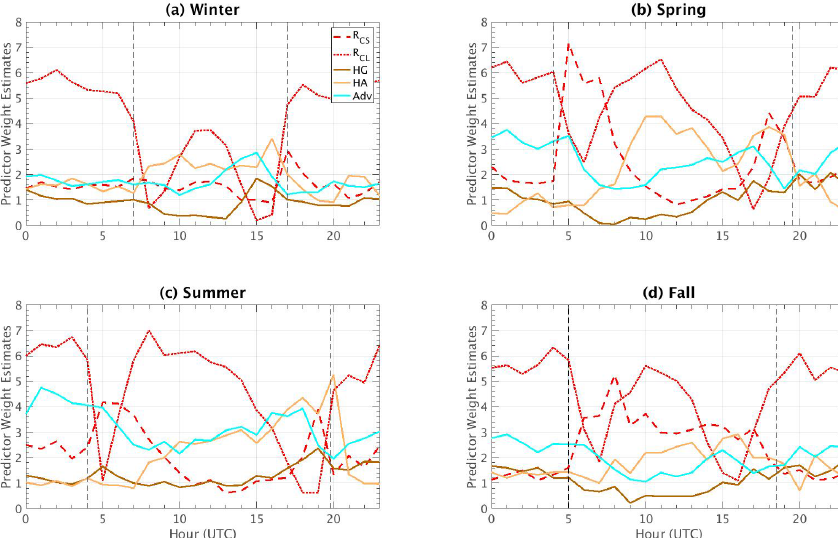
Figure 6. Diurnal cycle of the predictor importance estimate for each term of the model, for (a) winter, (b) spring, (c) summer, and (d) fall. Same colors as in Fig. 2a and b. Vertical dashed black lines are for sunrise and sunset mean